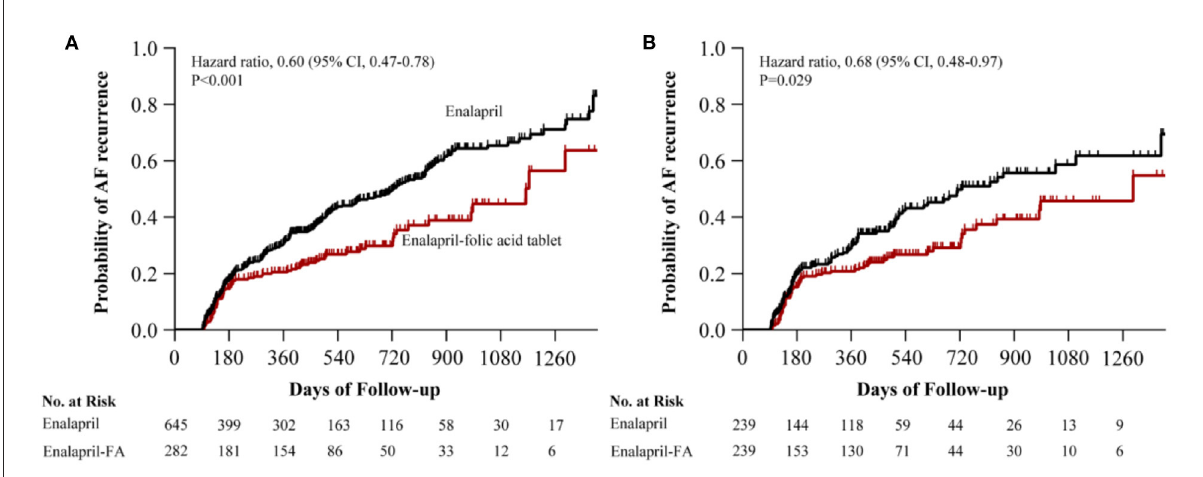
FIGURE3 Kaplan–Meier curves of cumulative probability of AF recurrence before PSM (A) and after PSM (B) . The HR after PSM was adjusted for age, sex, BMI, duration of AF, LAD, AF type, smoking status, alcohol drinking status, SBP, DBP, eGFR, Scr, UA, HbA1c, TC, TG, HDL-c, LDL-c, BNP, LVEF, additional ablation, beta-blockers, CCB, statins, MRA, diuretics, digoxin, AADs and history of disease (CAD, diabetes, HF, hyperlipidaemia, renal insufficiency). AF, atrial fibrillation; PSM, propensity score matching; HR, hazard ratio; CI, confidence interval; FA, folic acid; BMI, body mass index; LAD, left atrial diameter; SBP, systolic blood pressure; DBP, diastolic blood pressure; eGFR, estimated glomerular filtration rate; Scr, serum creatinine; UA, uric acid; TC, total cholesterol; TG, triglyceride; HDL-c, high-density lipoprotein cholesterol; LDL-c, low-density lipoprotein cholesterol; BNP, brain natriuretic peptide; LVEF, left ventricle ejection fraction; CCB, calcium channel blocker; MRA, mineralcorticoid recept antagonist; AADs, antiarrhythmic drugs; CAD, coronary heart disease; HF, heart failure.